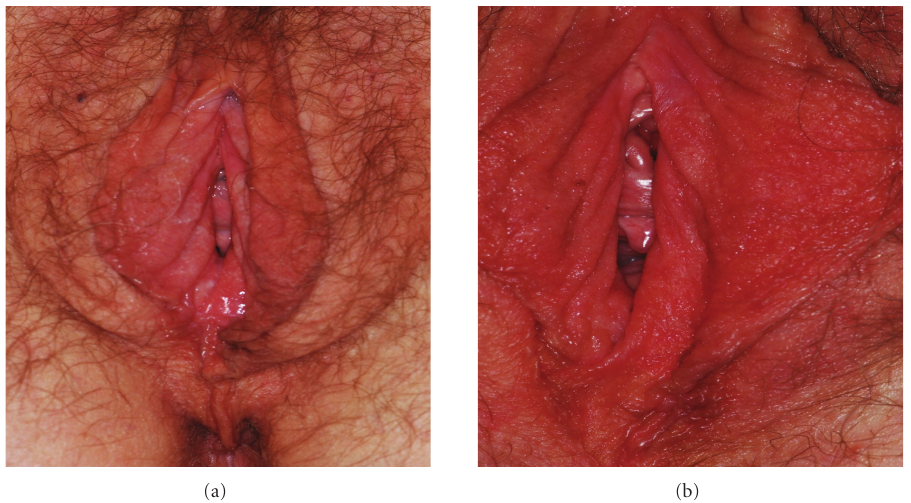
Figure 1: After treatment with beta-blocker (a). Acute flare